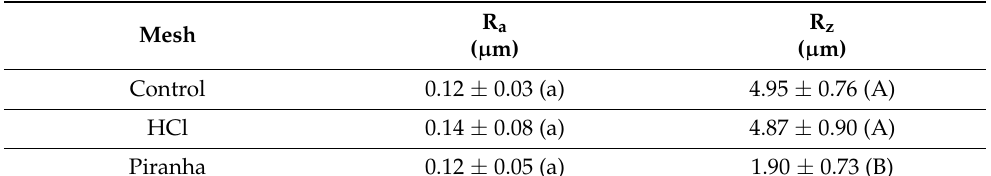
Table 2. Roughness values, R a and R z, for titanium alloy surfaces with different passivation treat- ments. Different letters in the same column denote statistically significant differences ( p < 0.05) between groups.